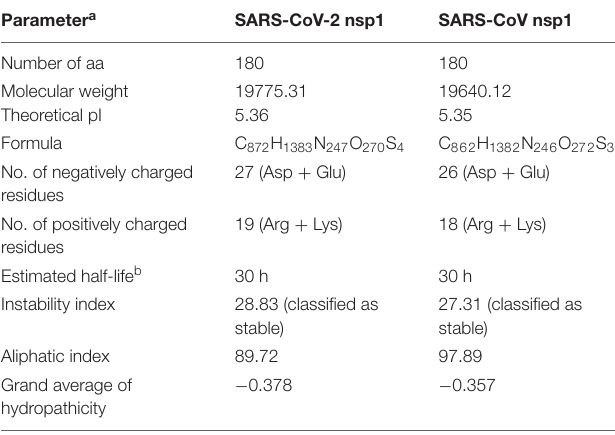
TABLE 1 | Physicochemical properties of SARS-CoV-2 and SARS-CoV